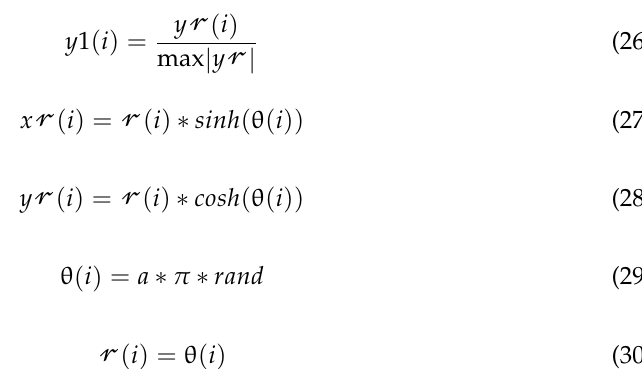
Figure 2. Hunting sequences adopted by the Bald Eagle Search.